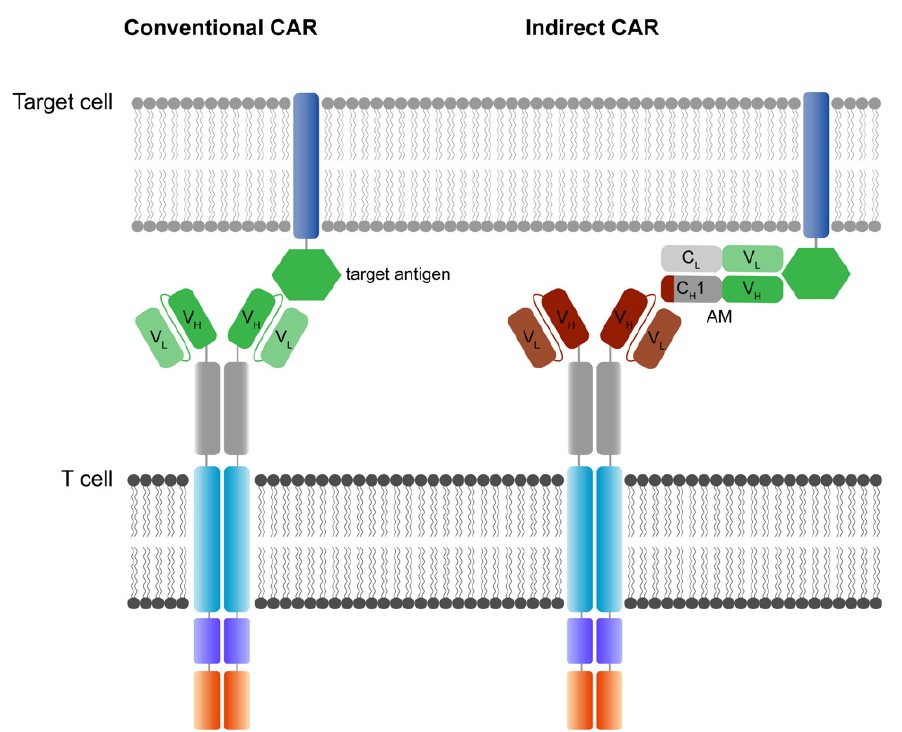
Figure 7. The designs of conventional and indirect CAR T cell technologies.